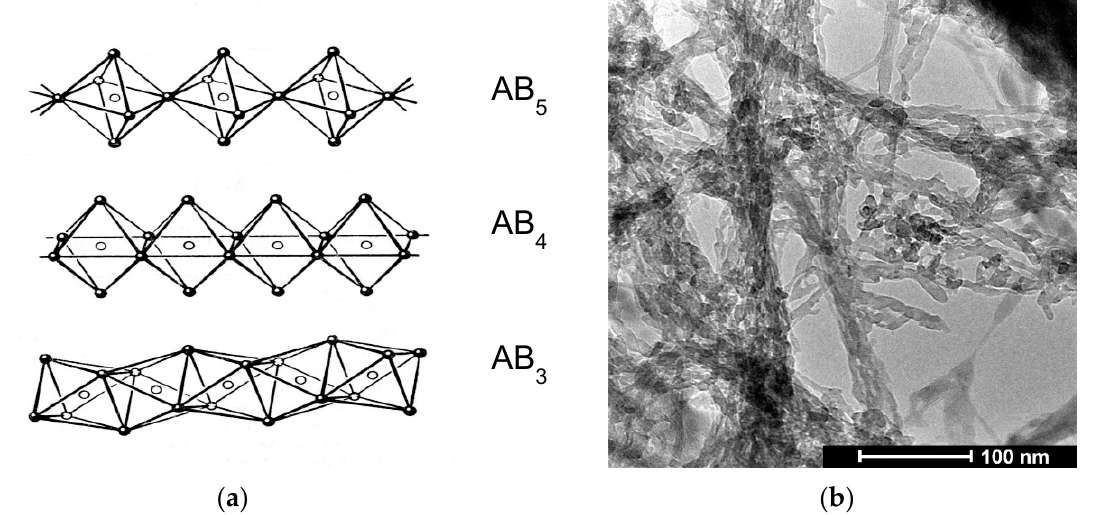
Figure 1. ( a ) Molecular chains of Al +3 cations (hollow balls) in anionic octahedral surroundings (solid balls) and corresponding stoichiometry of octahedral chains with the composition ABx. The side contacts and association of molecular chains with fibrils forms a 3D structure of raw PMOA. ( b ) TEM image of raw PMOA. Individual nanofibrils with a diameter of 5–7 nm and bundles of nanofibrils with a diameter of 20–50 nm is clearly seen.